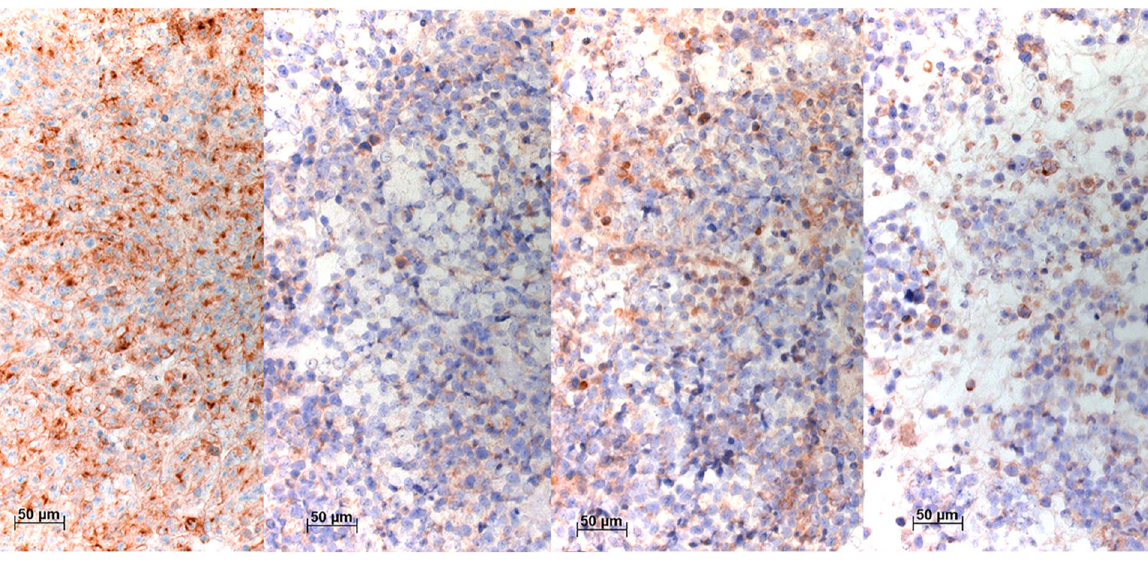
Fig. 3 Immunocytochemical stainings of NCI-H69s with VenA, AbcA, NovA, and TherA (left to right). VenA shows an intense membranous but also a cytoplasmic staining, the latter concentrated as dots, most likely representing accumulation within endoplasmic reticulum. AbcA stained less than half of the cells, whereas NovA and TherA stained approximately 50% of the cells, but in variable intensity. Bar 50 μ